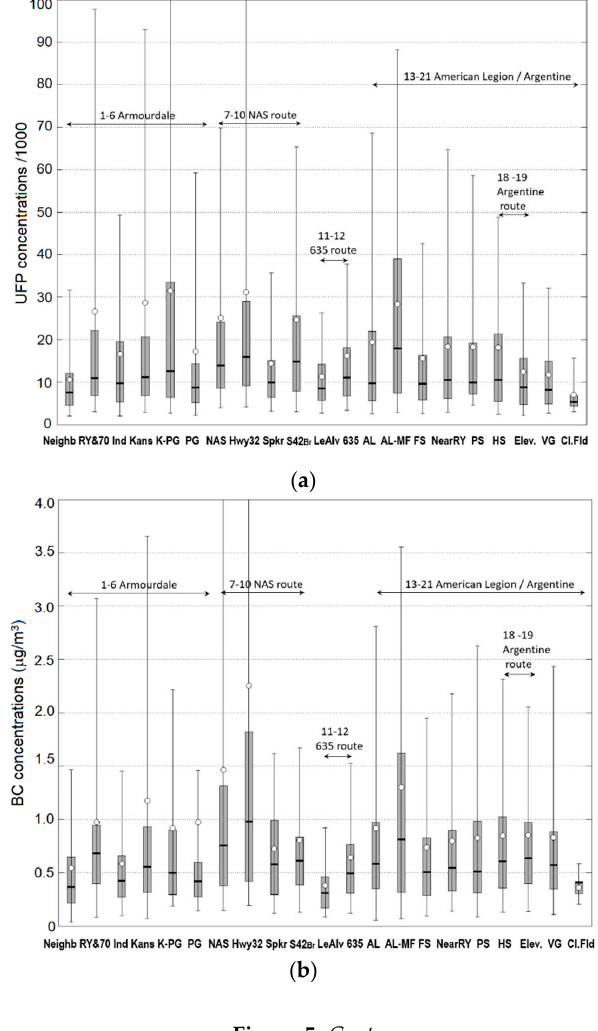
Figure 4. Comparison of distributions of observed BC concentrations at six stationary sites and at selected mobile monitoring areas representing concentrations around the six stationary